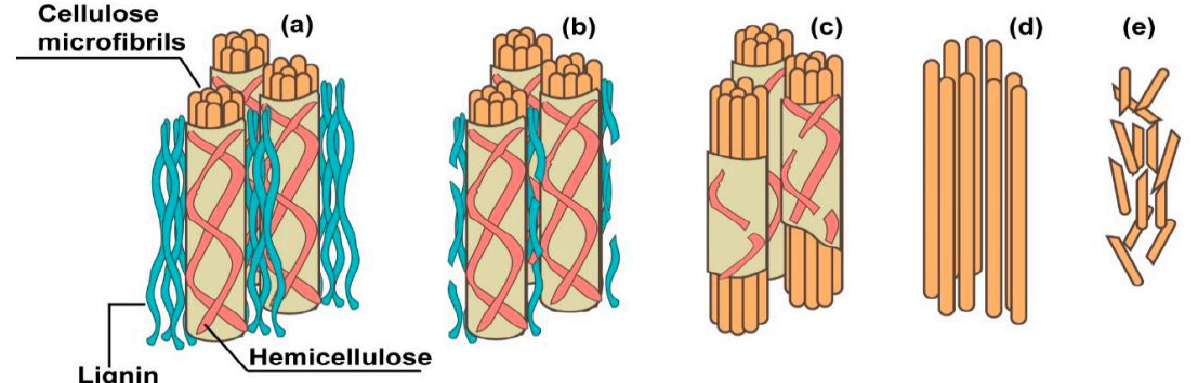
Figure 5. Schematic diagram of alkaline degradation mechanism of PFs. ( a ) major components of PFs; ( b ) Degradation of lignin and part of hemicellulose; ( c ) Degradation of hemicellulose; ( d ) Stripping of cellulose microfibrils; ( e ) Failure of cellulose microfibrils [81].